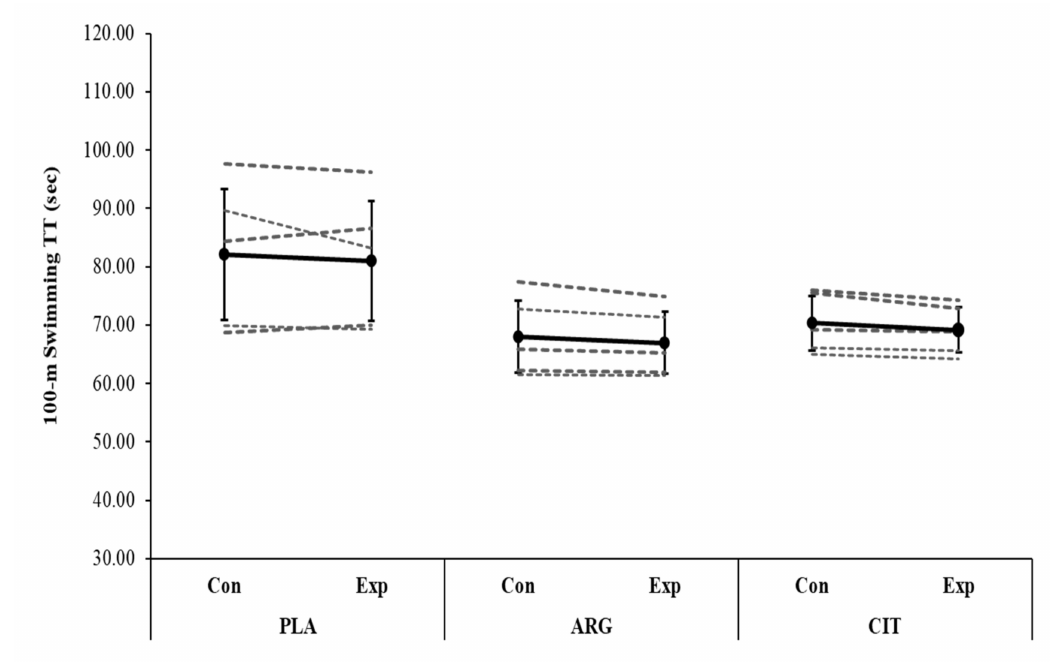
Figure 3. Group mean (SD) and individual 100 m swimming TT responses after 8-day L-citrulline or L-arginine or placebo supplementation are shown in the black and dashed lines, respectively. PLA, placebo; ARG, L-arginine; CIT, L-citrulline; Con, control trial; Exp, experimental trial; TT, time